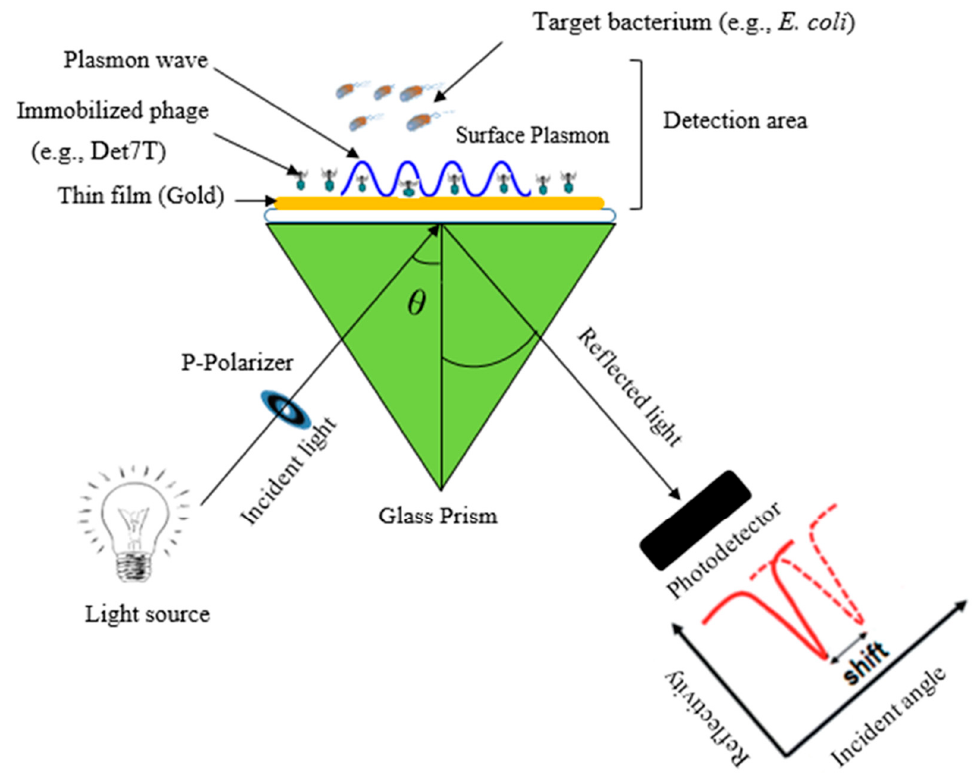
Figure 4. Schematic diagram illustrating the working principle of a surface plasmon resonance sensor (SPR) using bacteriophages.